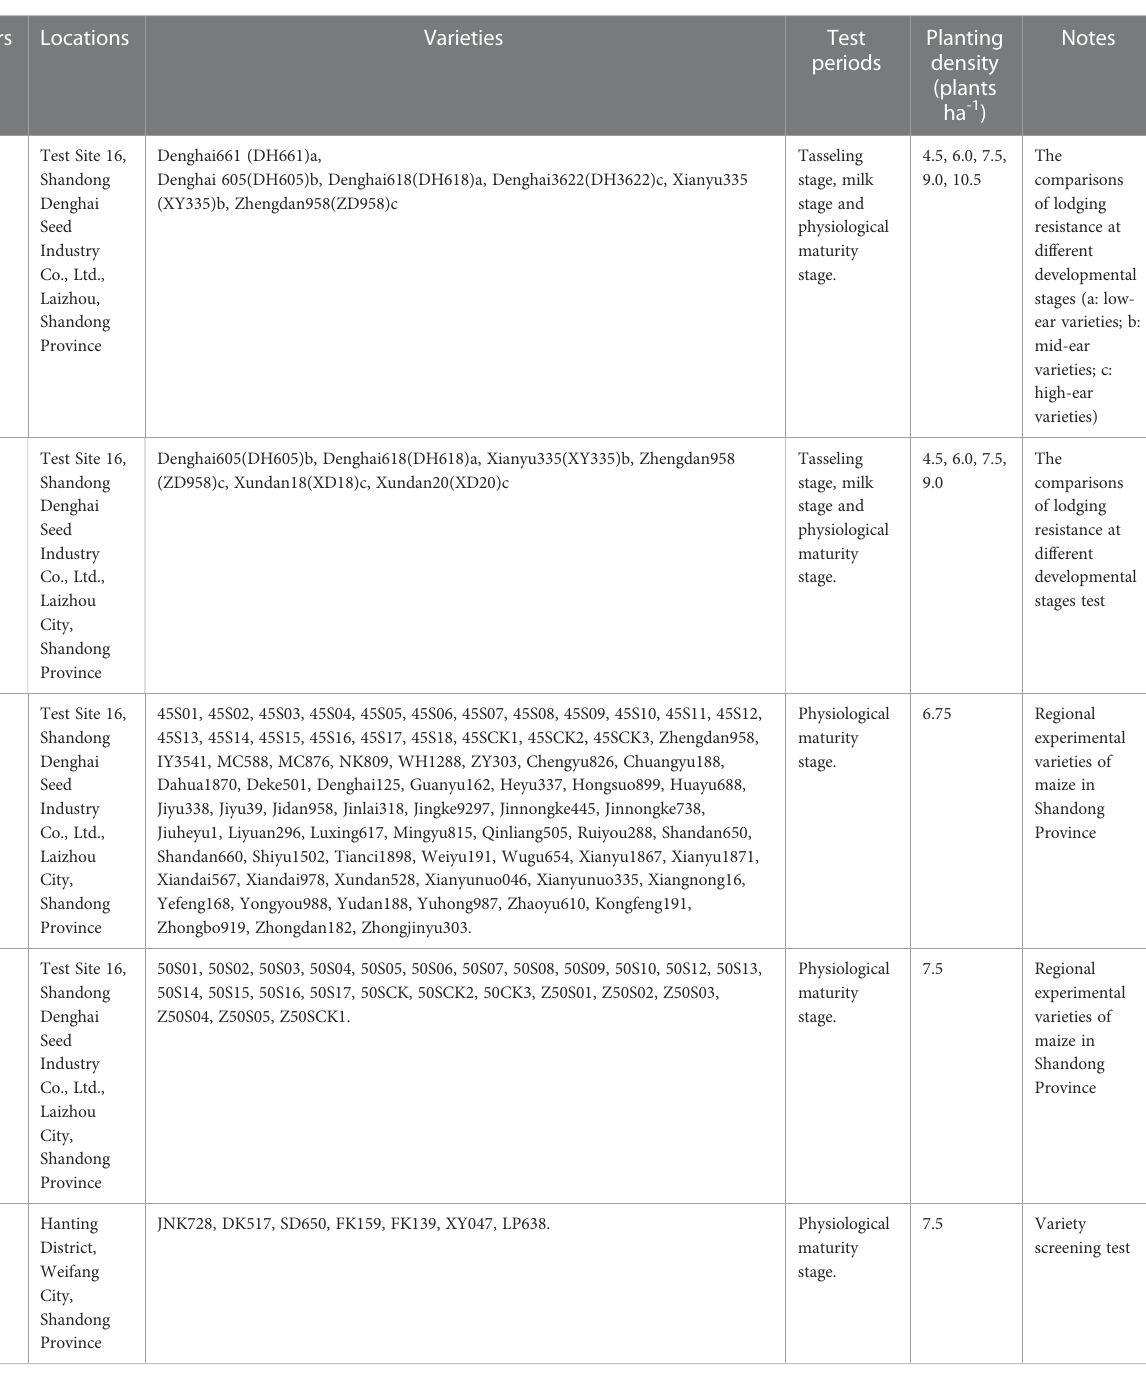
TABLE 1 Test varieties in three